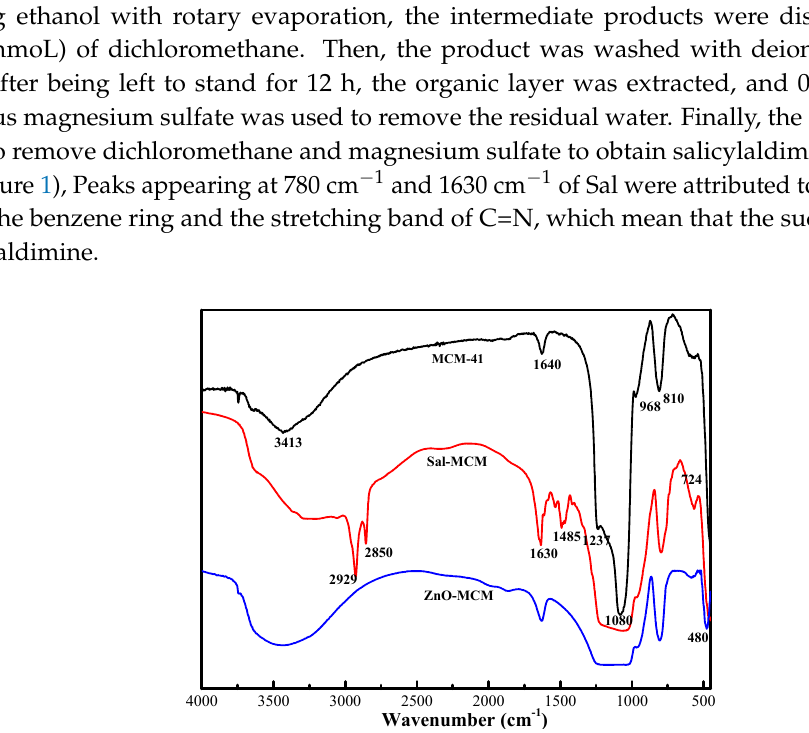
Figure 1. Fourier-transform infrared spectroscopy (FTIR) spectra of MCM-41, Sal, Sal-MCM, and ZnO-MCM.